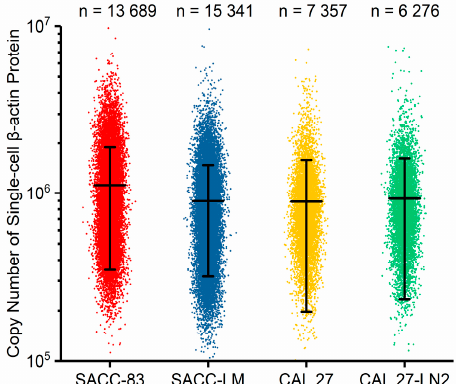
Figure 4. Scatter plots of the copy numbers of single-cell β -actin proteins for salivary adenoid cystic carcinoma parental cell line (SACC-83) ( n cell = 13,689), salivary adenoid cystic carcinoma lung metastasis cell line (SACC-LM) ( n cell = 15,341), oral carcinoma cell line (CAL 27) ( n cell = 7357), and oral carcinoma lymphatic metastasis cell line (CAL 27-LN2) ( n cell = 6276). These results indicated that the developed instrument was capable of collecting beta-actins from ~10,000 single cells.